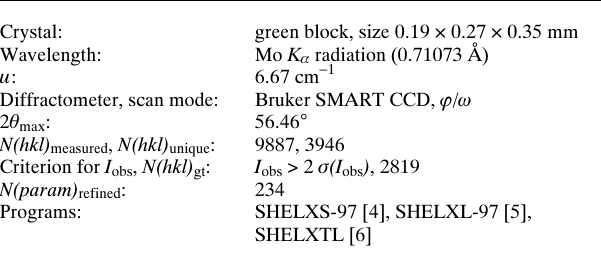
Table 1. Data collection and handling.